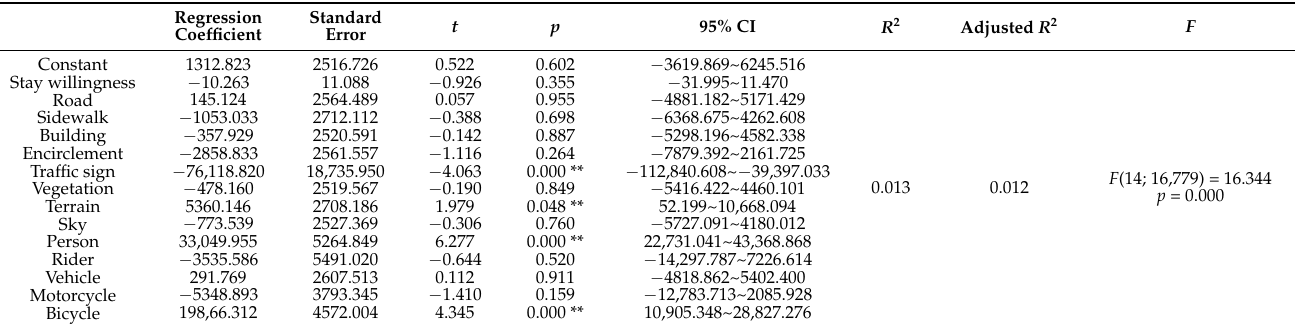
Table 5. OLS analysis with number of reviews as the dependent variable ( n =